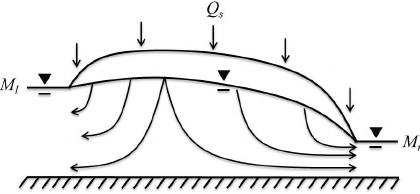
Figure 6. Schematic of the discrete example consisting of three mi- croscale elements with a Dirichlet boundary condition on the right side ( µ b ) and a source/sink in each element ( q l , q c , q r